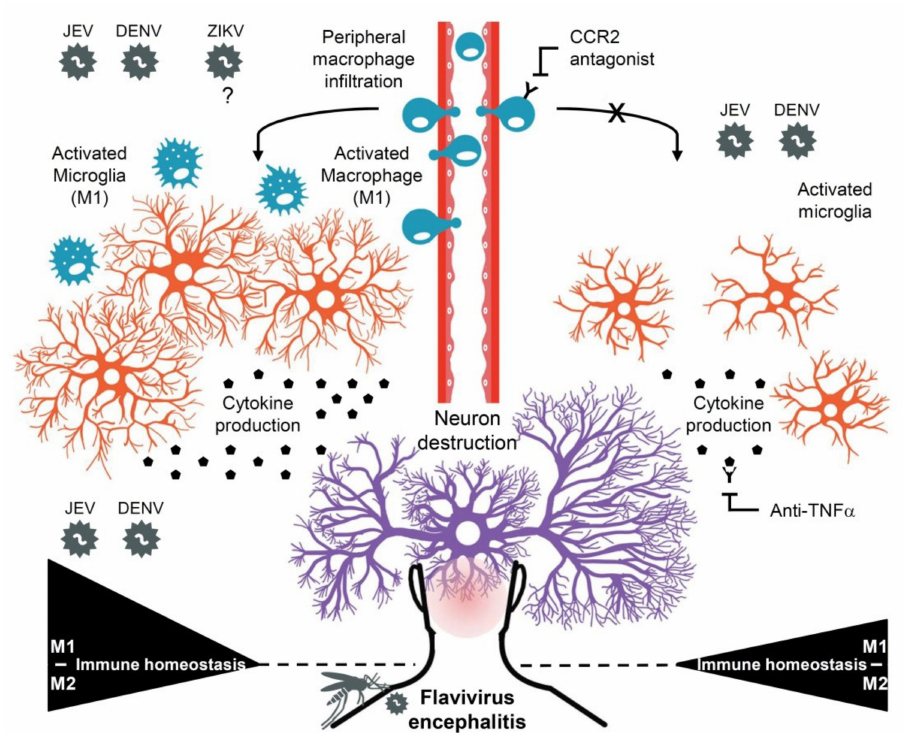
Figure 6. A hypothetical model of type 1 macrophage polarization and immune responses involved in JEV- and DENV-induced encephalitis. Flavivirus infections, such as JEV and DENV, but not ZIKV, in the brain could cause macrophage infiltration into the CNS, followed by type 1 polarization under the encephalitic microenvironment. In cooperation with polarized resident microglia, type 1 macrophages and their immune responses may have exacerbated neurotoxicity and neuropathic severity, while blockading CCR2, which is critical for peripheral macrophage infiltration, and TNF- α may confer neuroprotection against M1